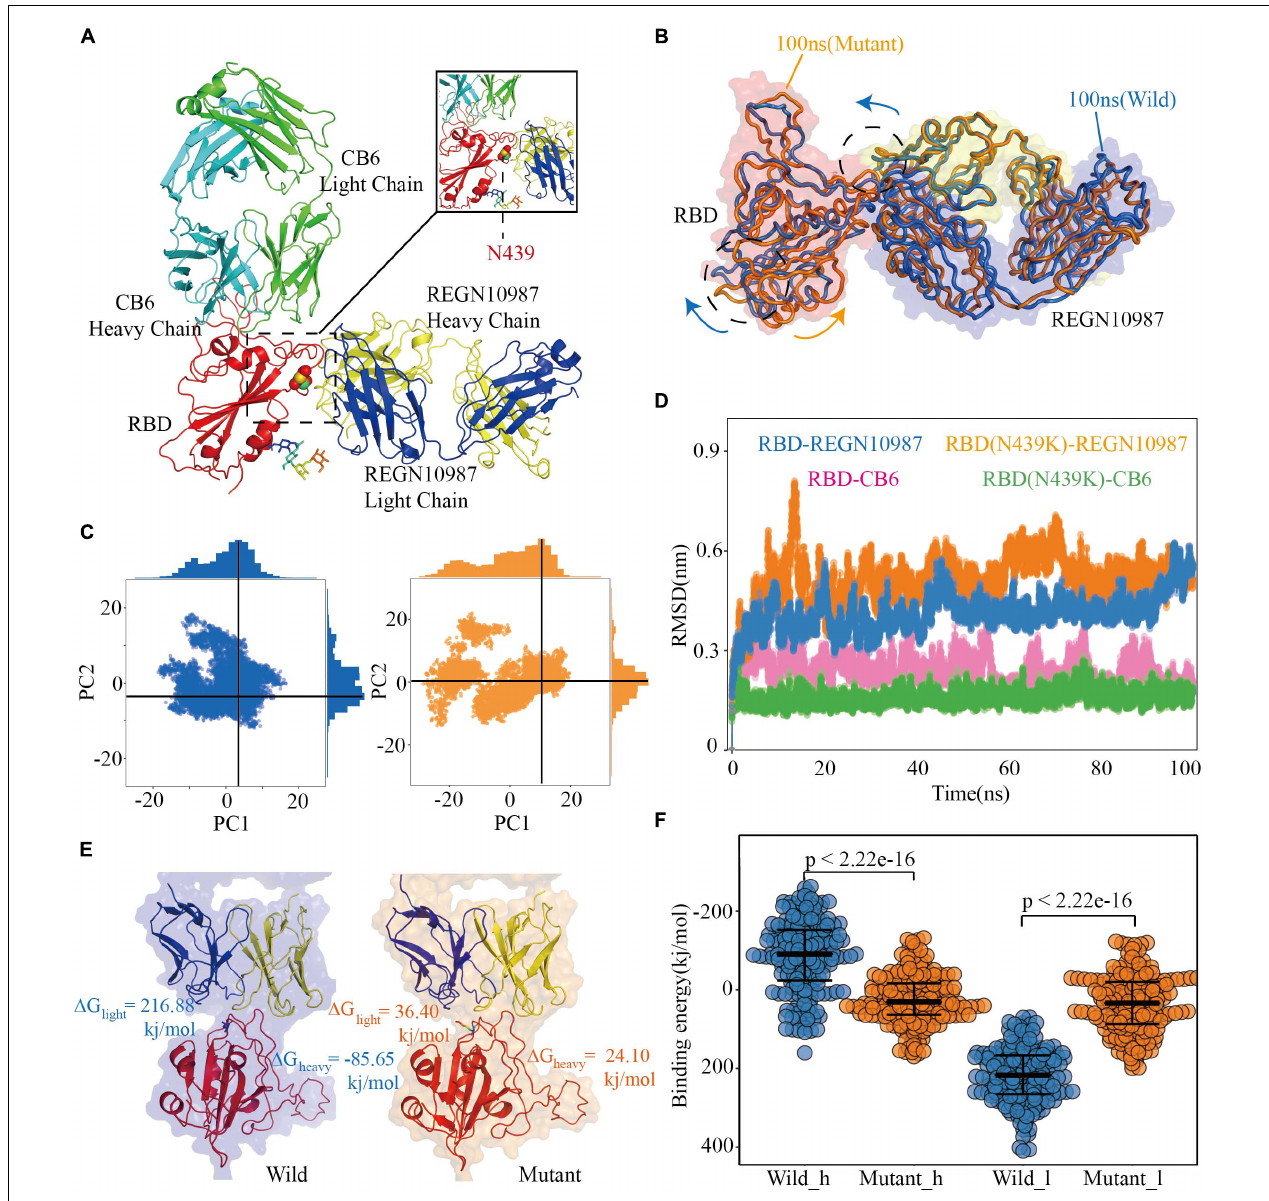
FIGURE 4 | Structural and energetic details of both wild and mutant RBD-mAbs interactions. (A) Crystal structures of RDB-CB6/REGN10987 complexes, the RBD is colored red, CB6 heavy and light chains are represented as marine and green, respectively, REGN10987 heavy chain is colored yellow and light is blue, and the 439 residues are described as the sphere. (B) Characteristic dynamic fluctuations of both RBD-REGN10987 and RBD(N439K)-REGN10987 complexes. Mutant-type (100 ns) and wild-type (100 ns) are colored by orange and blue, respectively. (C) Dynamic conformations are projected on to the principal vectors (PC1 and PC2). Red and blue indicate mutant-type and wild-type 100 ns MD trajectories, respectively. (D) The RMSD of the receptor-binding motif in four complexes during the 100-ns MD simulations. (E) The binding free energies for both complexes of the mAb REGN10987 (including heavy and light chains), the color schemes are the same in (A,C) . (F) The binding free energies of 200 configurations at an interval of 100 ps from the last 20 ns simulations. The t -test was conducted to check the statistical significance of the difference between two systems of binding free energies. A p -value of < 0.05 indicates that the difference is statistically significant (95% confidence interval). The color scheme is the same as that in (C)